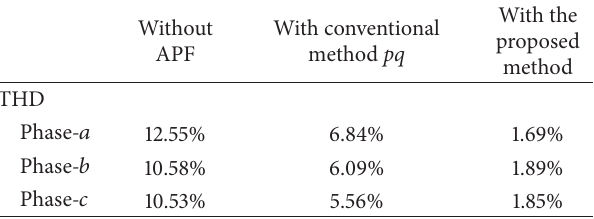
Figure 13: Active filter currents waveform with the proposed con- trol.